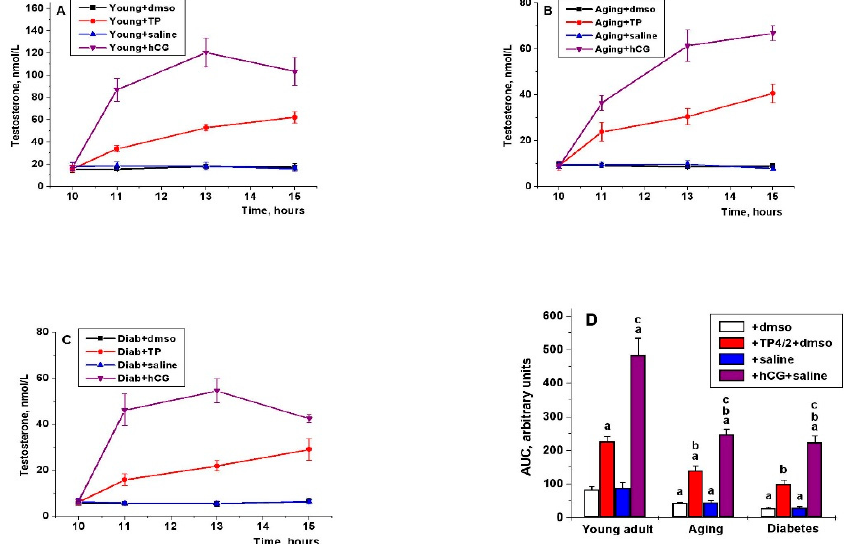
Figure 2. The stimulating e ff ects of a single administration of TP4 / 2 and hCG on the blood testosterone levels in the young adult, aging and diabetic male rats. ( A ) Young + dmso—young adult rats plus DMSO, i.p.; Young + TP—young adult rats plus TP4 / 2, 20 mg / kg, i.p.; Young + saline—young adult rats plus saline, s.c.; Young + hCG—young adult rats plus hCG, 20 IU / rat, s.c.; ( B ) Aging + dmso—aging rats plus DMSO, i.p.; Aging + TP—aging rats plus TP4 / 2, 20 mg / kg, i.p.; Aging + saline—aging rats plus